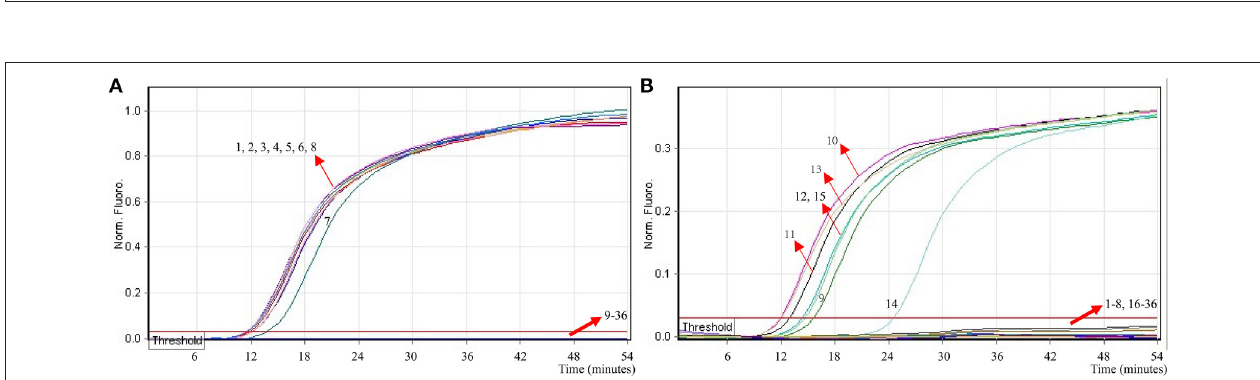
FIGURE 7 | The sensitivity of multiplex MERT-LAMP assay for simultaneously detecting two target pathogens. Two sets of MERT-LMAP primers targeting ipaH and invA genes were simultaneously added to a reaction tube. (A,B) were simultaneously generated from Cy5 (labeling Shi -EFIP of ipaH ) and Hex (labeling Sal -EFIP of invA ) channels, respectively. Sensitivity of multiplex-MERT-LAMP for simultaneously detecting Shigella (A) and Salmonella (B) was monitored by real-time format, and signals 1, 2, 3, 4, 5, 6, 7, 8, and 9 represent DNA levels of 2.5ng, 250pg, 25pg, 2.5pg, 250fg, 125fg, 62.5fg, and 31.25fg per vessel and negative control. The LoD of multiplex MERT-LAMP assay for Shiglla detection was 62.5fg per tube, and the LoD of multiplex MERT-LAMP for Salmonella detection was 125fg per reaction.